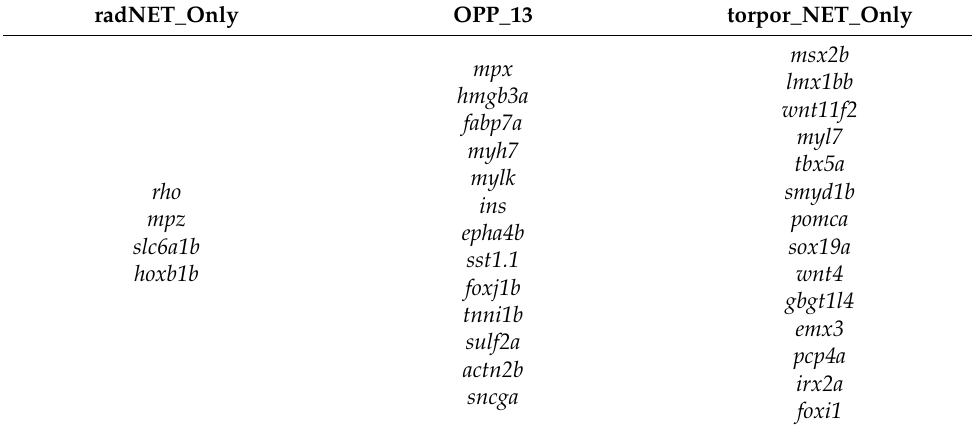
Table 2. Genes found to be dysregulated between the radiation group and torpor + radiation group as determined from the integrated NetNC